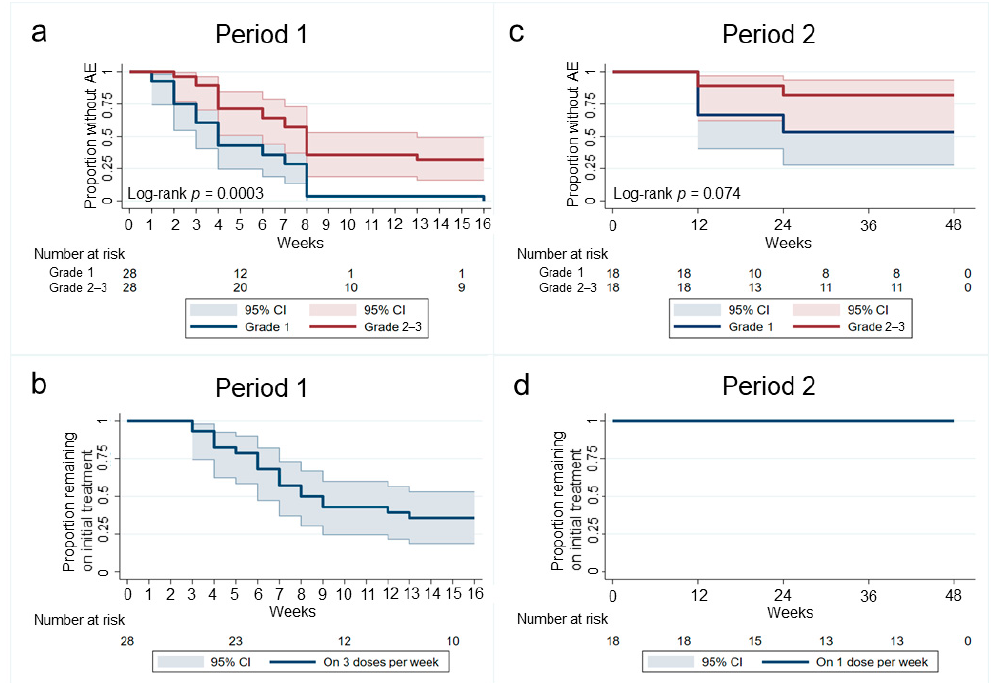
Figure 2. Kaplan–Meier Survival curves demonstrating time to adverse events in period 1 and period 2. Figures 2 ( a , c ) demonstrate the proportion of men in period 1 and period 2 who remained without adverse events over the corresponding study periods, as well as those who developed grade 1 (blue line) and grade 2 or 3 adverse events (red line). Figures 2 ( b , d ) demonstrate the proportion of men who remained on the initially prescribed imiquimod treatment in period 1 (3 doses per week) and period 2 (1 dose per week). Table 2. Adherence to imiquimod by week of follow-up during period 1 and period 2.